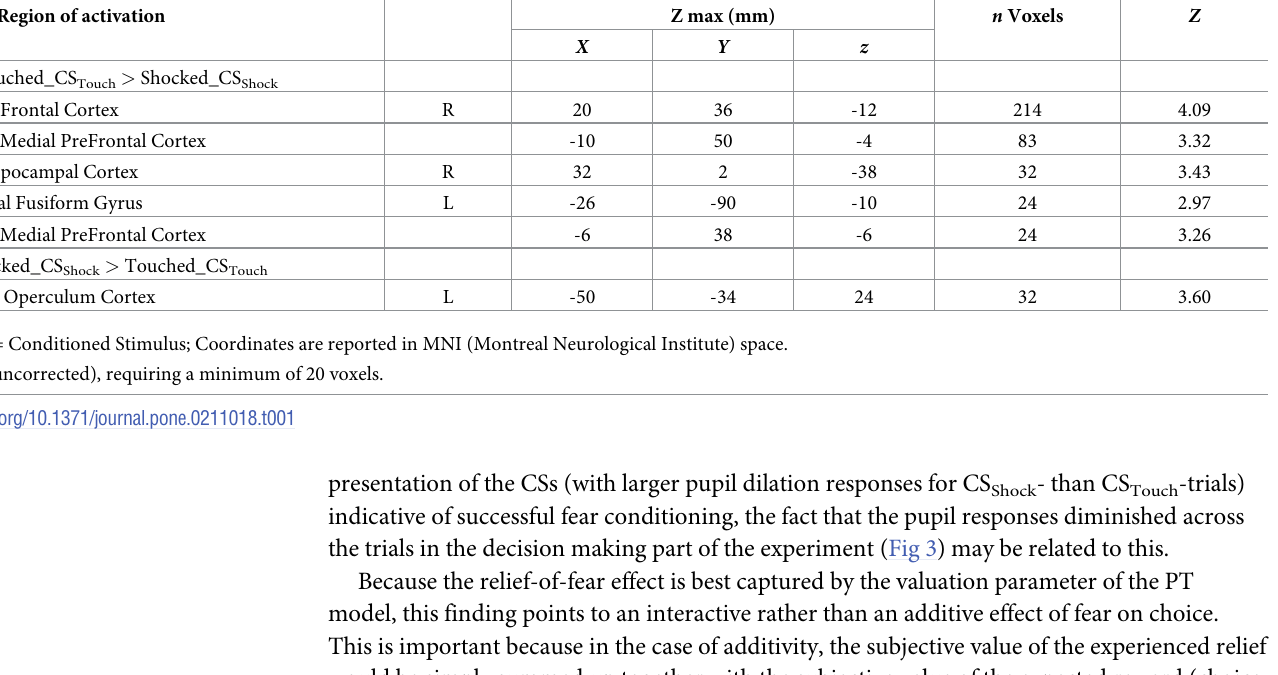
Table 1. Brain activation related to CS cue presentation (Touched_CS Touch vs. Shocked_CS Shock ). Contrast Region of activation